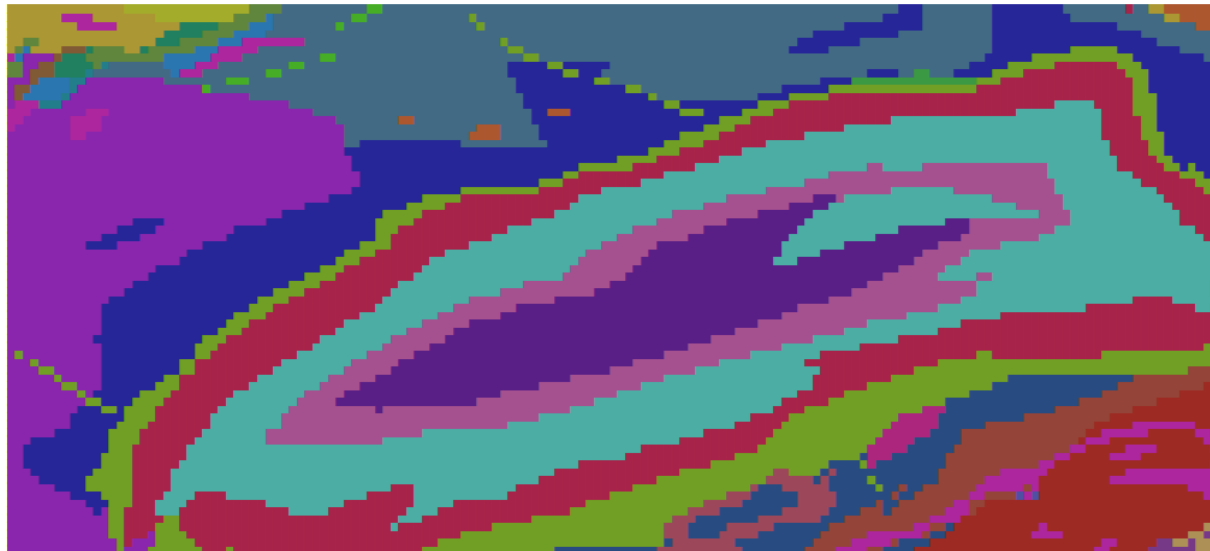
Table 2. Landsat 4-5 TM band ratios that are used as input features for the calibration and classification datasets. Justification for each ratio is included. Adapted from Cracknell and Reading (2014).